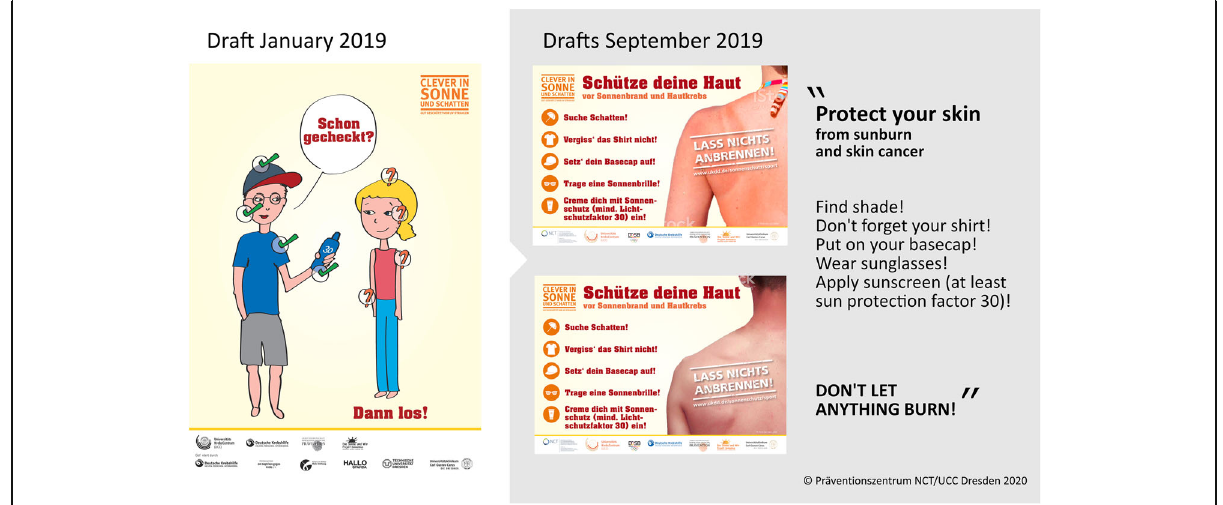
Fig. 1 Adaption of the behavior self-check poster draft after PPP group meetings in partner school